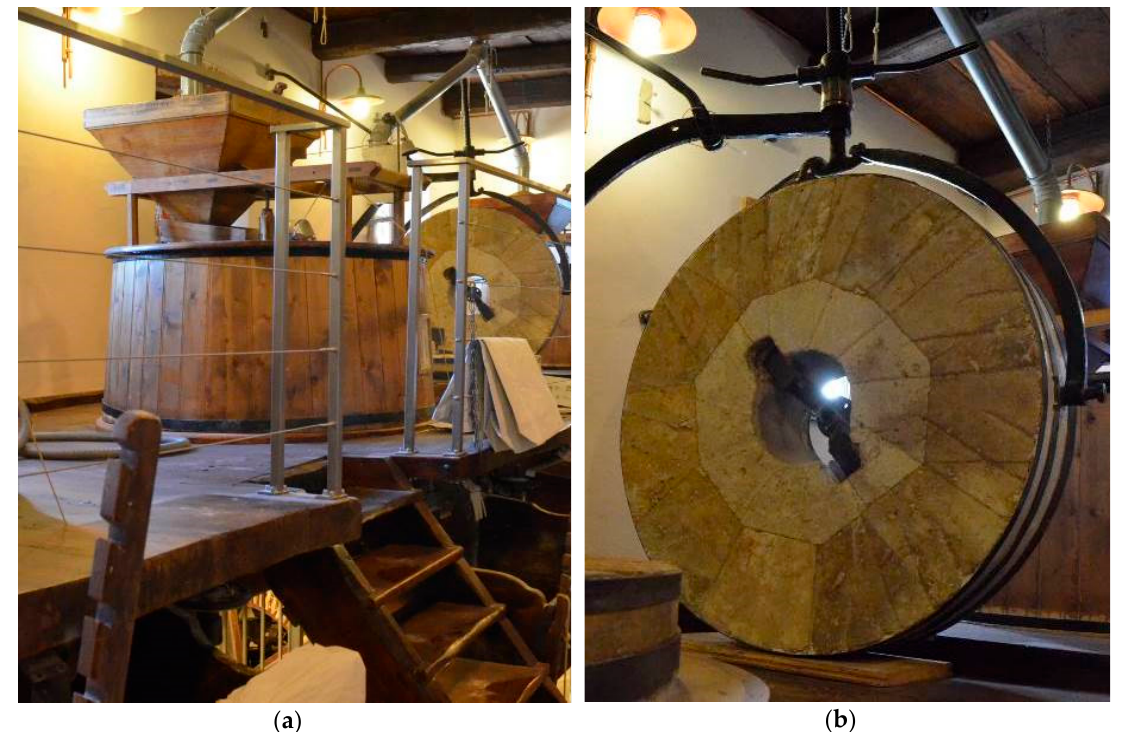
Figure 19. Stone floor of Riviera mill: ( a ) Tun and hopper; ( b ) lifted runner stone.